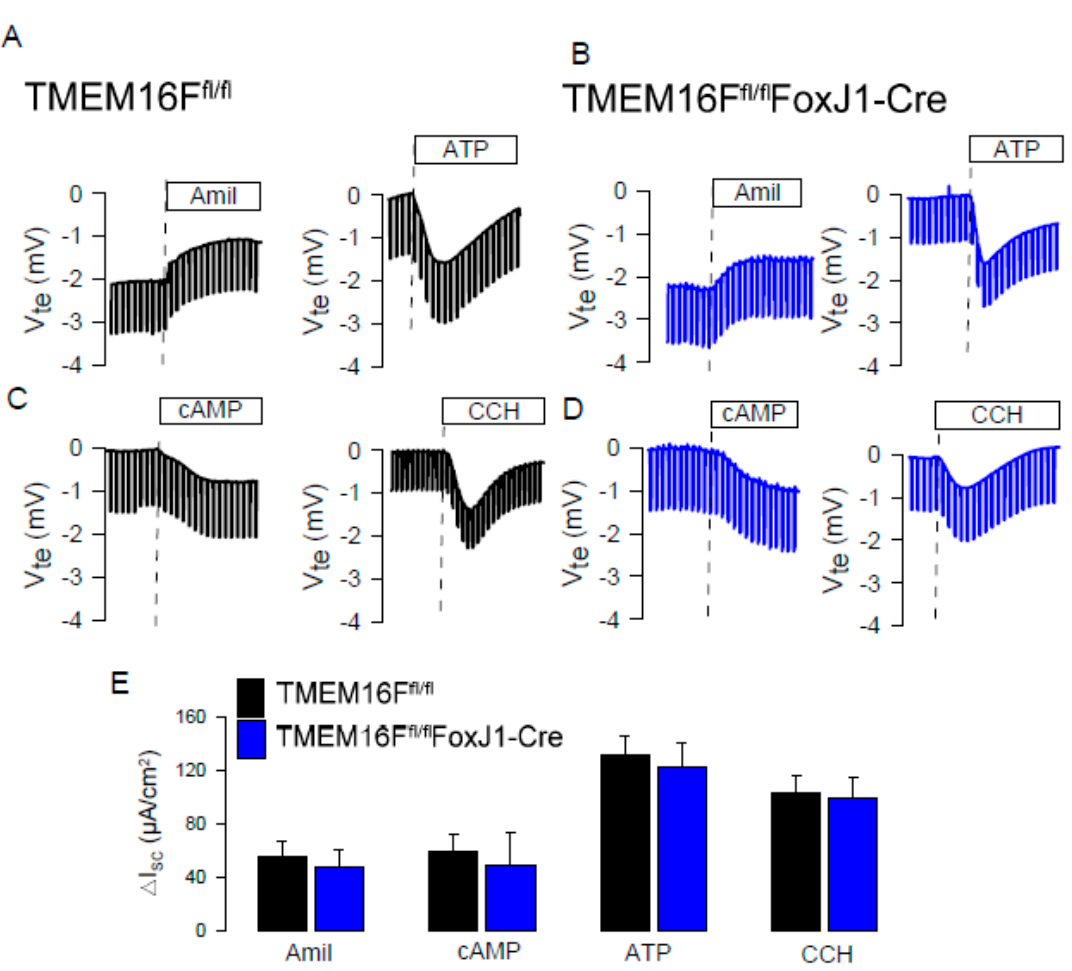
Figure 8. TMEM16F does not contribute to ion transport in mouse airways. Original Ussing chamber recordings obtained under open circuit conditions in tracheas from TMEM16F fl / fl (wild type) ( A , C ) and TMEM16F fl / fl FoxJ1Cre (TMEM16F knockout in ciliated airway epithelial cells) ( B , D ) mice. Inhibition of epithelial Na + absorption (via ENaC) by amiloride (10 µ M), activation of CFTR by IBMX and forskolin (100 µ M and 2 µ M; cAMP), and activation of Ca 2 + -dependent Cl − secretion by luminal ATP (100 µ M) and basolateral carbachol (CCH; 100 µ M) were comparable in wild type and TMEM16F-knockout tracheas. ( E ) Summaries of the calculated short circuit currents. Mean ± SEM (4 tracheas for each series).